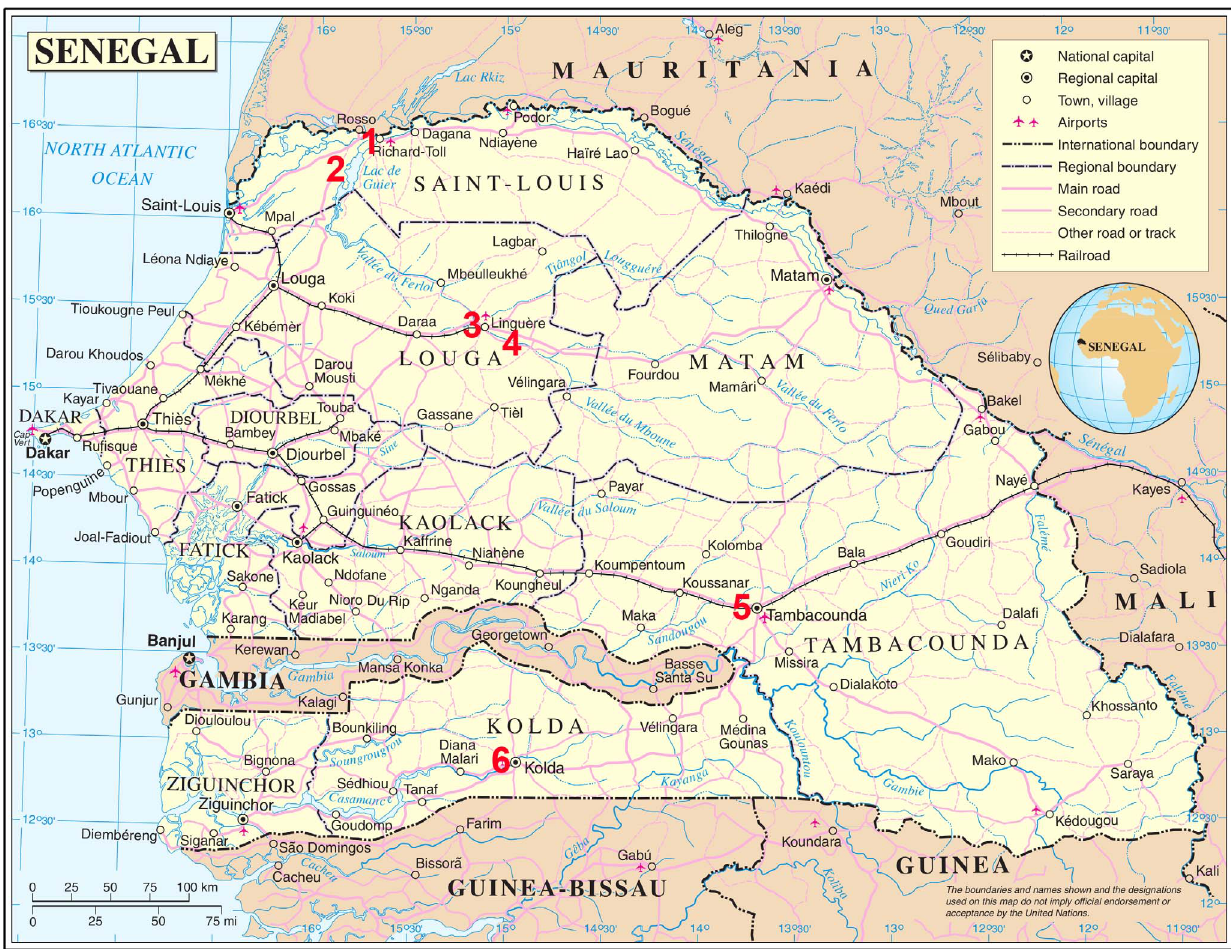
Figure 1. Map showing the location of the survey sites across Senegal. The survey sties are numbered in red. GPS coordinates: 1. Richard Toll=16 u 27 9 40.71 0 N, 15 u 41 9 15.29 0 W, 2. Nder=16 u 15 9 33.50 0 N, 15 u 53 9 2.13 0 W, 3. Linguiere=15 u 23 9 34.33 0 N, 15 u 6 9 55.87 0 W, 4. Barkedji= = 15 u 16 9 38.46 0 N, 14 u 51 9 55.48 0 W, 5. Tambacounda=13 u 46 9 8.00 0 N, 13 u 40 9 2.00 0 W, 6. Kolda=12 u 53 9 58.27 0 N, 14 u 56 9 39.37 0 W. The regions of Senegal are also shown on the